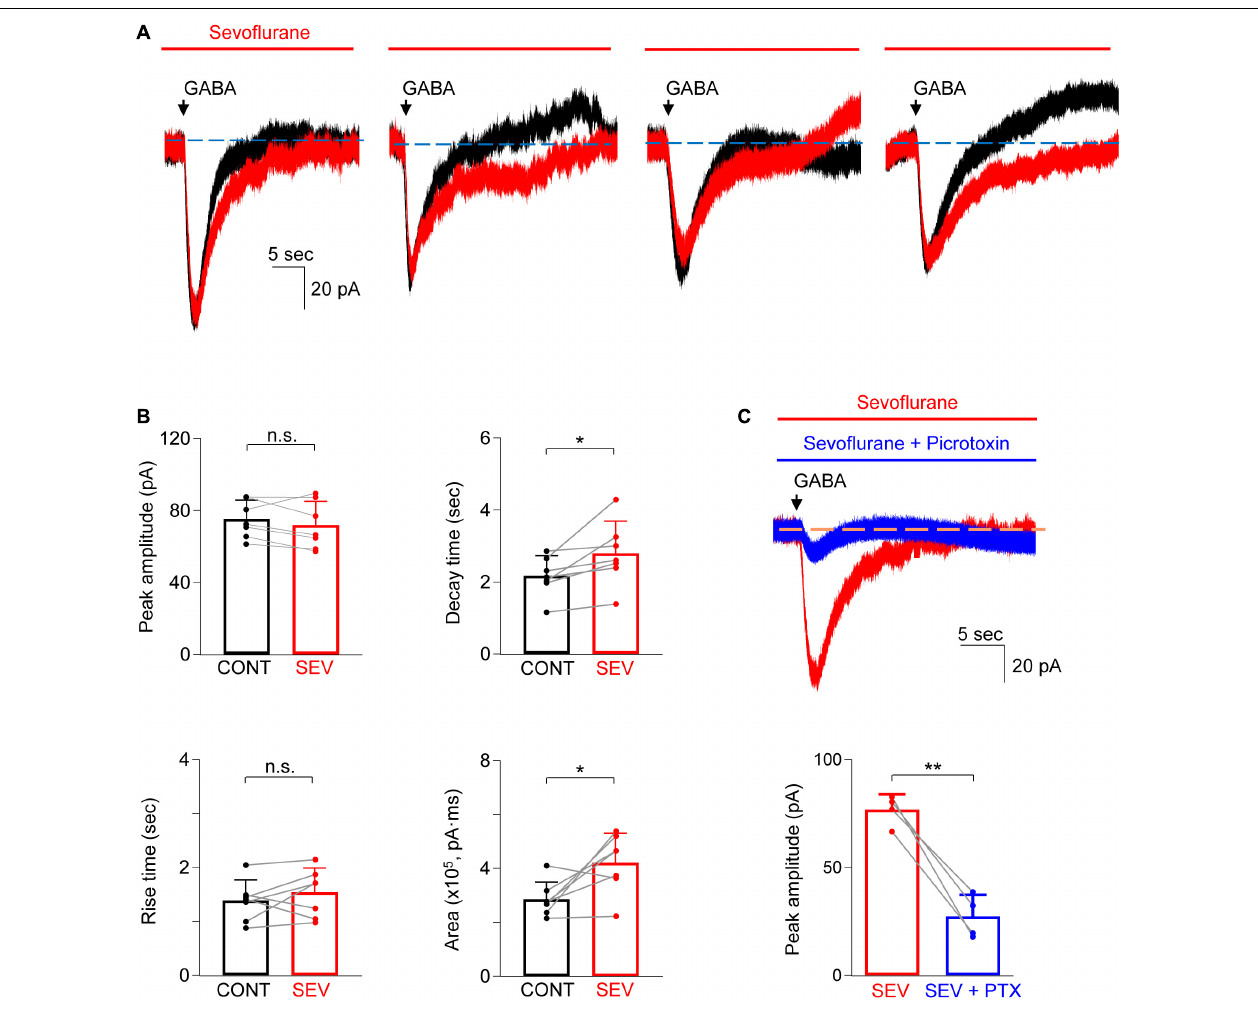
FIGURE 4 | Sevoflurane potentiated GABA-evoked current in astrocytes. (A) Representative traces show the GABA-evoked responses before and during sevoflurane (SEV) treatment from four different astrocytes. Note the different shapes of the late phase of the current decay in both the absence and presence of sevoflurane. (B) Summarized data for peak amplitude, rise time, decay time, and charge transfer (area). n = 7, * P < 0.05, n.s.: not significant, paired Student’s t -test. CONT: control. (C) Representative traces (top) and summarized data (bottom) show that GABA-evoked current in the presence of sevoflurane (SEV) is inhibited by picrotoxin (PTX, 0.5 mM, 5–10 min). n = 4, ** P = 0.003, paired Student’s t -test. Data are presented as mean ±